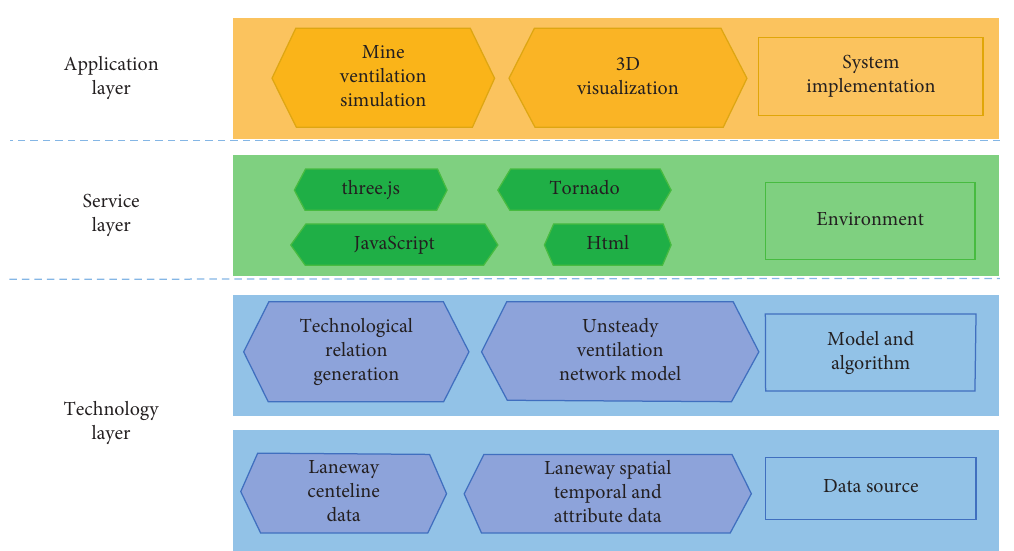
Figure 3: The architecture of 3D VentCloud